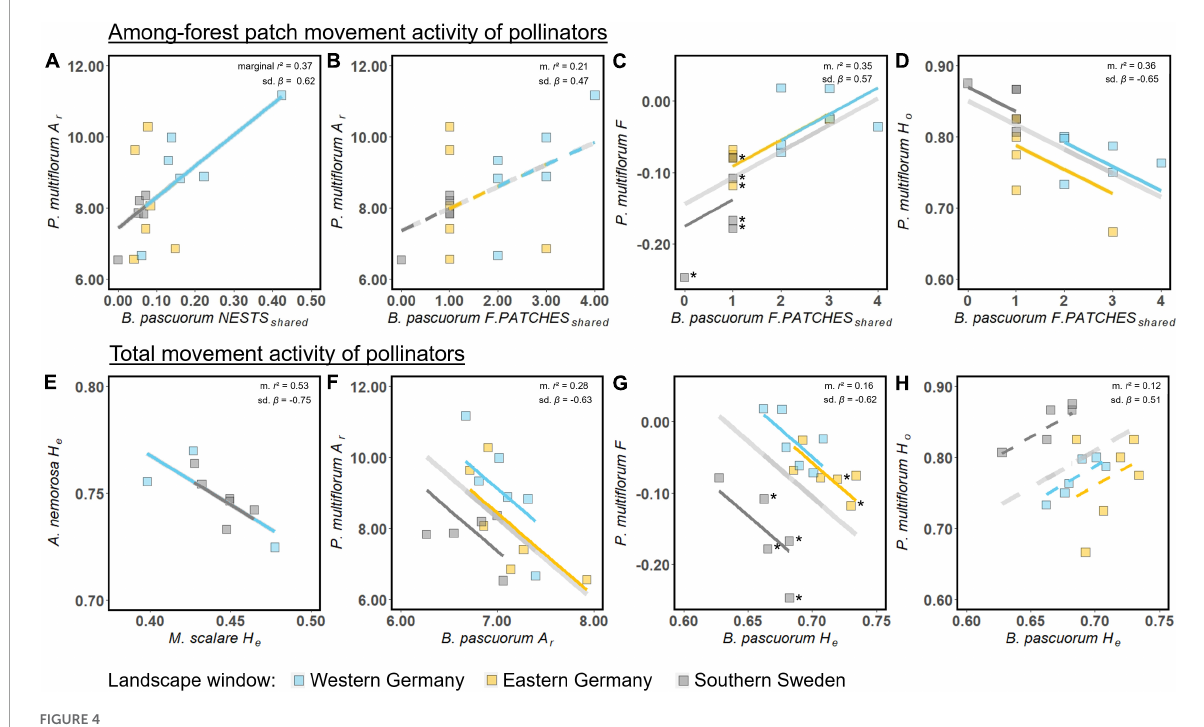
FIGURE4 Effects of genetic indicators of pollinator movement activity among the forest patches (A–D) and total pollinator movement activity (E–H) of B. pascuorum and M. scalare on population genetic diversity of the forest herbs P. multiflorum and A. nemorosa , respectively, according to LMMs. Shown are the global effect of a model (bright gray line) and the effects in each landscape window, with p < 0.05 (solid lines) and p < 0.1 (dashed lines). The marginal r 2 and standardized regression coefficient (sd. β ) are shown in the upper-right part of each figure. All models for testing H2 with p < 0.1 are shown here. F. PATCHES shared : FOREST-PATCHES shared . The filled squares are the raw data. Forest herb populations with a significant negative F are marked with